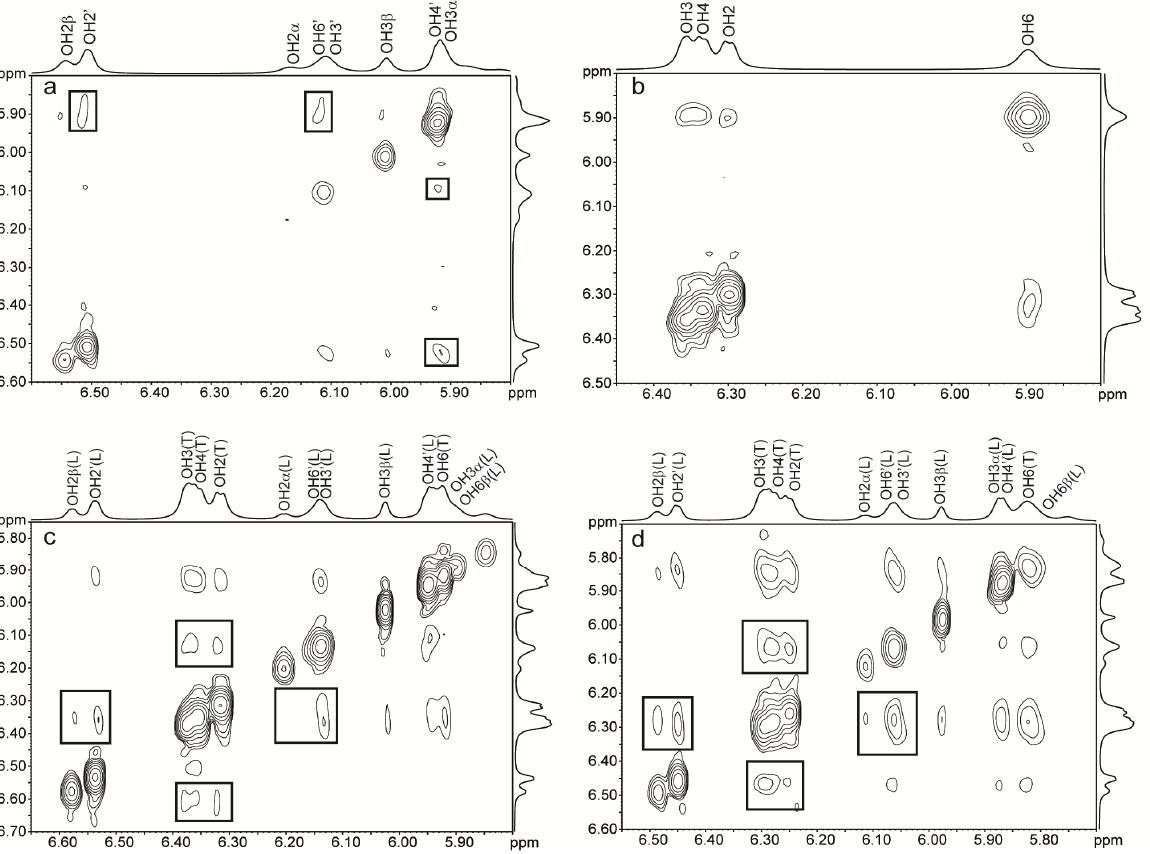
Figure 5. ROESY 1 H-NMR spectra at –5 °C of ( a ) lactose 203 mg/mL, ( b )